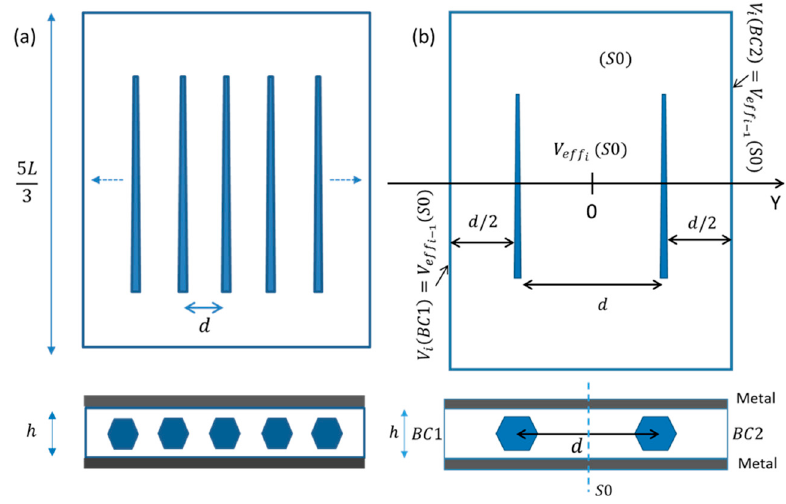
Figure 10. ( a ) Schematics of a regular horizontal assembly of wires. ( b ) Elementary cell structure composed of two wires illustrating the boundary condition calculation method.